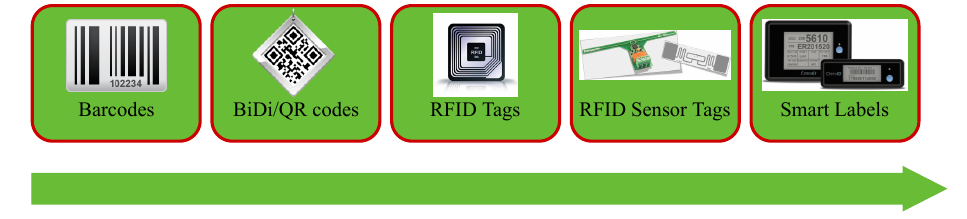
Figure 1. Technological evolution of identification